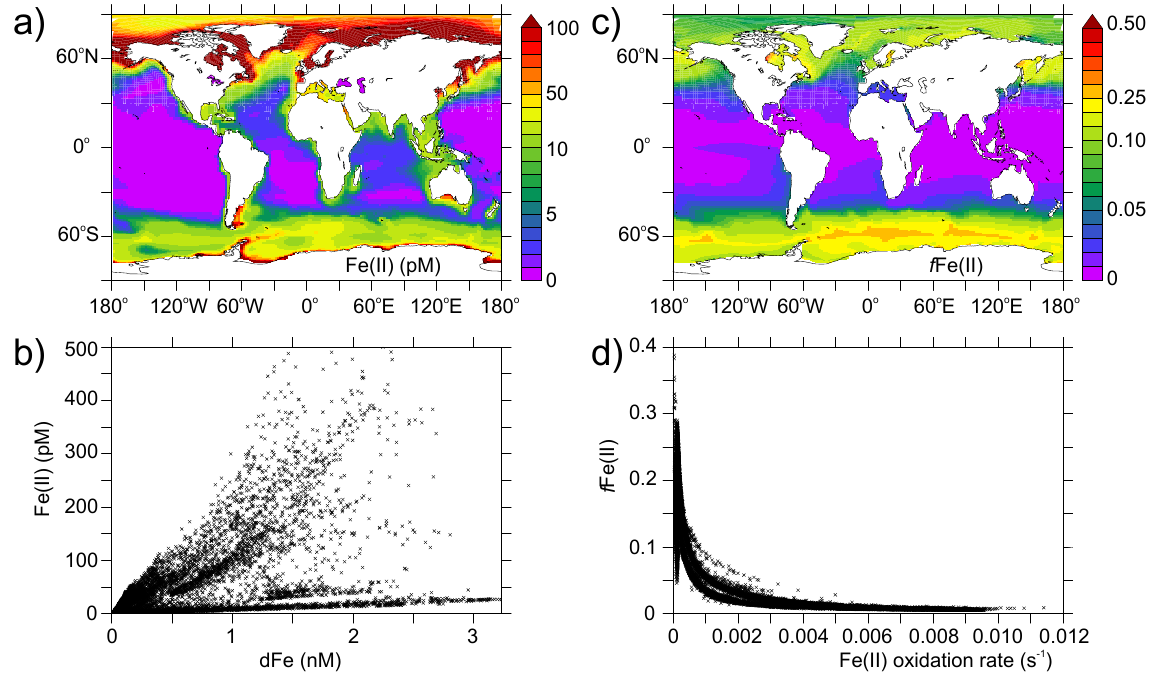
Fig. 2. Annually averaged surface (a) dissolved Fe(II) (pM) and (b) its relationship to dFe (nM), and (c) the annually average surface proportion of the dFe pool present as Fe(II) (fFe(II)) and (d) its relationship to the oxidation rate constant (s − 1 )